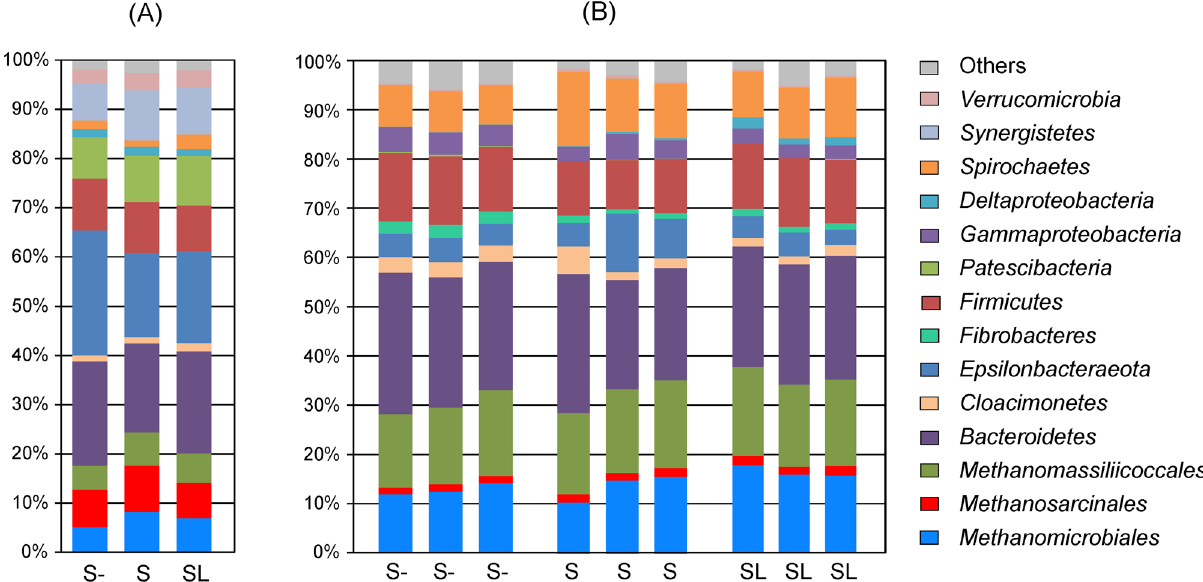
Figure 5. The relative abundance of taxonomic groups of microorganisms according to 16S rRNA gene profiling in microcosms derived from ( A ) the sediment slurry (Tom1) and ( B ) manure slurry (Tom3). S-, control microcosms with no supplements; S and SL, microcosms amended with sulfate, and sulfate + lactate, respectively. Note that manure slurry samples were analysed in manure slurry from the manure lagoon (Tom3), and corresponding microcosms were characterised by analysing their 16S rRNA gene sequences. At least 11,000 16S rRNA gene reads (on average 33,316 for Tom1 and 25,760 reads for Tom3 samples) were used to reveal microbial community composition. Sulfate and lactate amendments had little effect on the composition of the microbial community of the sedi- ment slurry from solid–liquid separation lagoon (Tom1), and all three samples were dominated by methanogenic archaea (18.3% to 25.4% of total 16S rRNA gene reads), members of the phyla Bacteroidetes (18.1–21.1%), Campy- lobacteraeota (17.2–25.3%), Firmicutes (9.4–10.6%), Patescibacteria (8.4–10.0%), and Synergistetes (7.4–10.2%) (Fig. 5A). Deltaproteobacteria accounted for 1.4–1.8% and were represented by Smithella sp., syntrophic degrad- ers of low molecular weight organics 17 . Lineages with known capability for dissimilatory sulfate reduction were not found in any of the Tom1 microcosms. The only detected lineage known to be involved in the sulfur cycle, bacteria of the genus Sulfurimonas (Campylobacterota), were present below the detection limit in the control